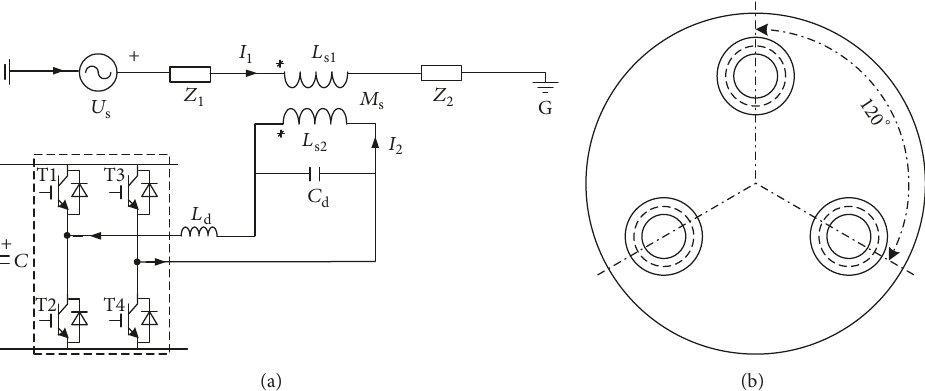
Figure 1: (a) Schematic diagram of the voltage compensation type active SFCL (single-phase connection). (b) Layout diagram of the three individual single-phase superconducting